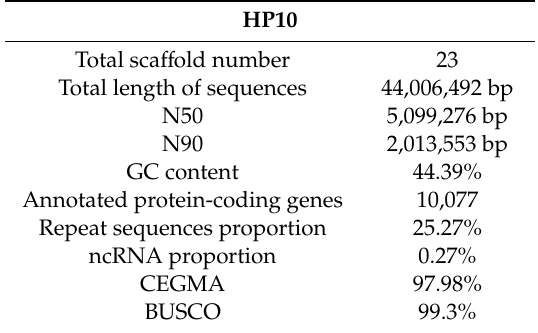
Table 1. Summary of H. perniciosus HP10 genome assembly and annotation